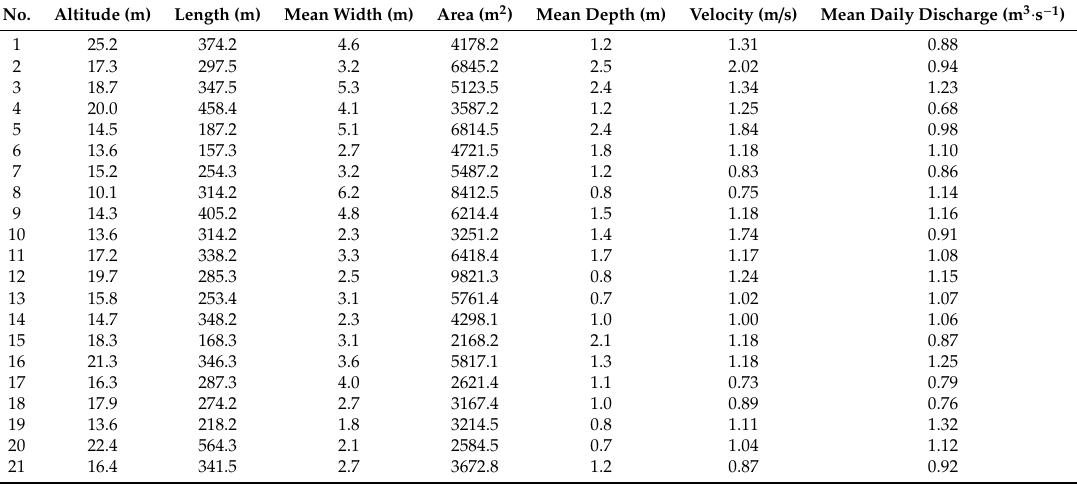
Table 1. Limnological characteristics of 21 study sites located in the upper parts of the Geum